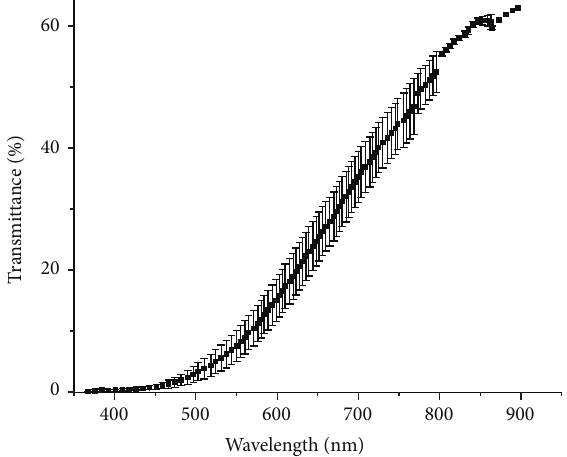
Figure 3: UV-Vis transmission behavior of PCSA monolithic cylin- ders used in this study prior to the pulverization stage. Monolithic aerogel densities of thesynthesized samples fell in therangeof 0.317– 0.5 gm/cm 3